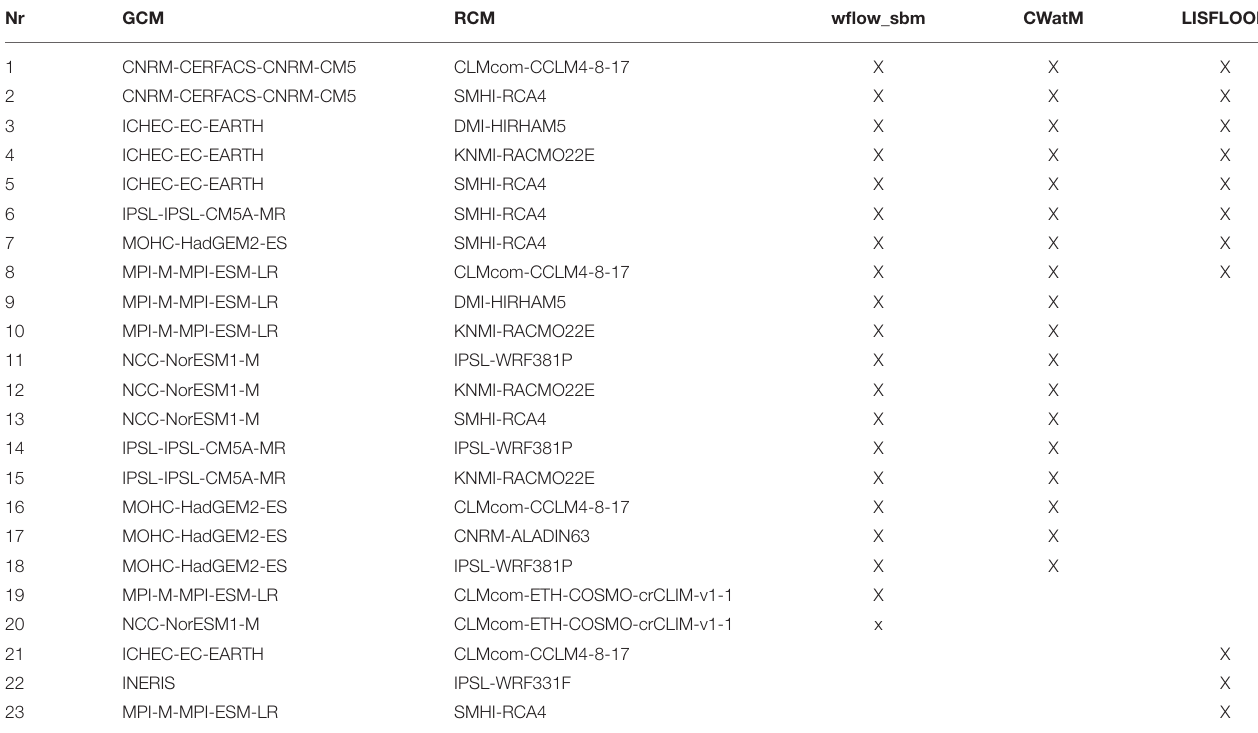
TABLE 2 | Overview of CORDEX simulations available for the three hydrological models, the X indicates that the hydrological model was run with this CORDEX GCM-RCM combination.